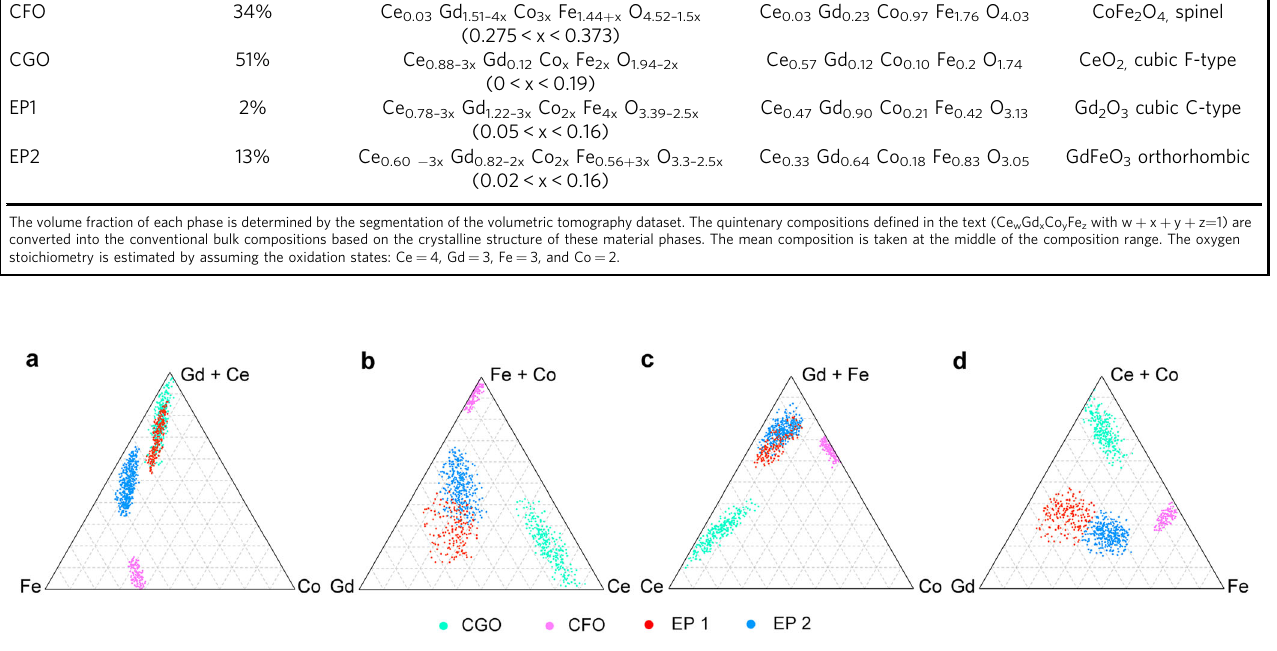
Fig. 6 Simulated ternary phase diagrams. The elemental relationships determined by linear fi tting analysis are used to simulate four ternary phase diagrams ( a Fe-Co-(Gd + Ce); b Gd-Ce-(Fe + Co); c Ce-Co-(Gd + Fe); d Gd-Fe-(Ce + Co)) to be compared with the data in Fig. 4. See Supplementary Fig. S6 and S7 for all 6 phase diagrams.